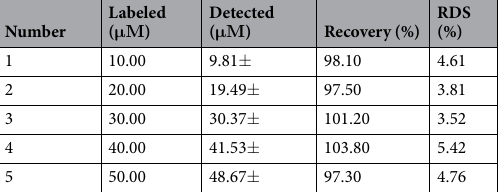
Table 1. Serum sample analysis and the comparison with standard samples (n =